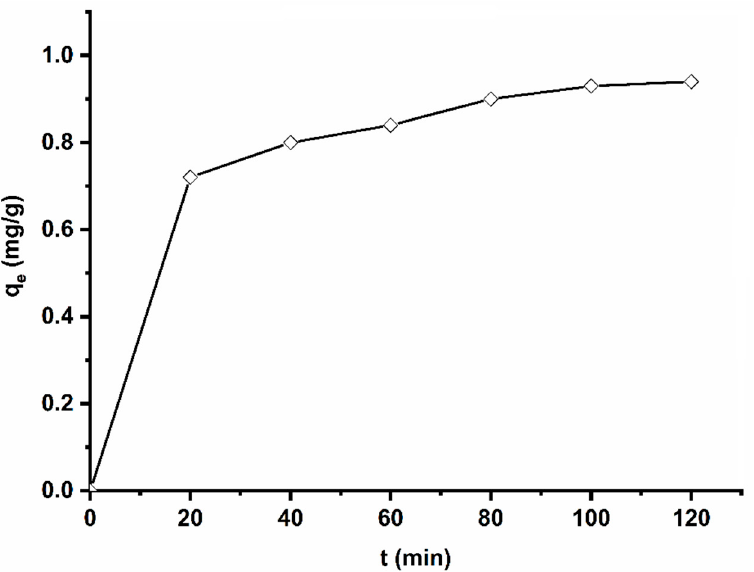
Figure 6. Influence of contact time on MO adsorption on AS. Experimental conditions: C 0 = 32.7 mg/g, m = 100 mg, V = 25 mL, T = 25 °C, pH = 6.